Question: How would you classify this visualization?
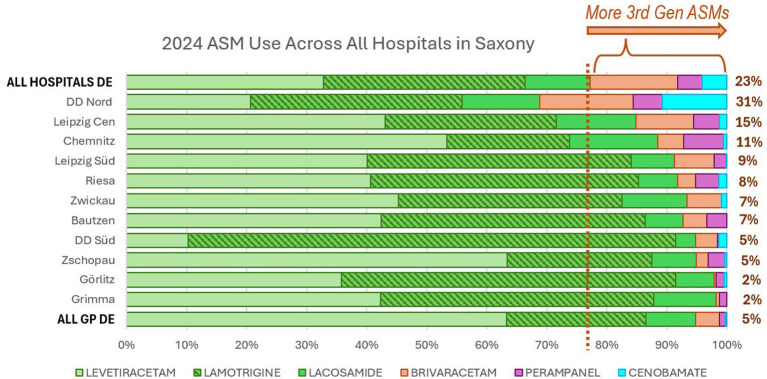
Answer: bar